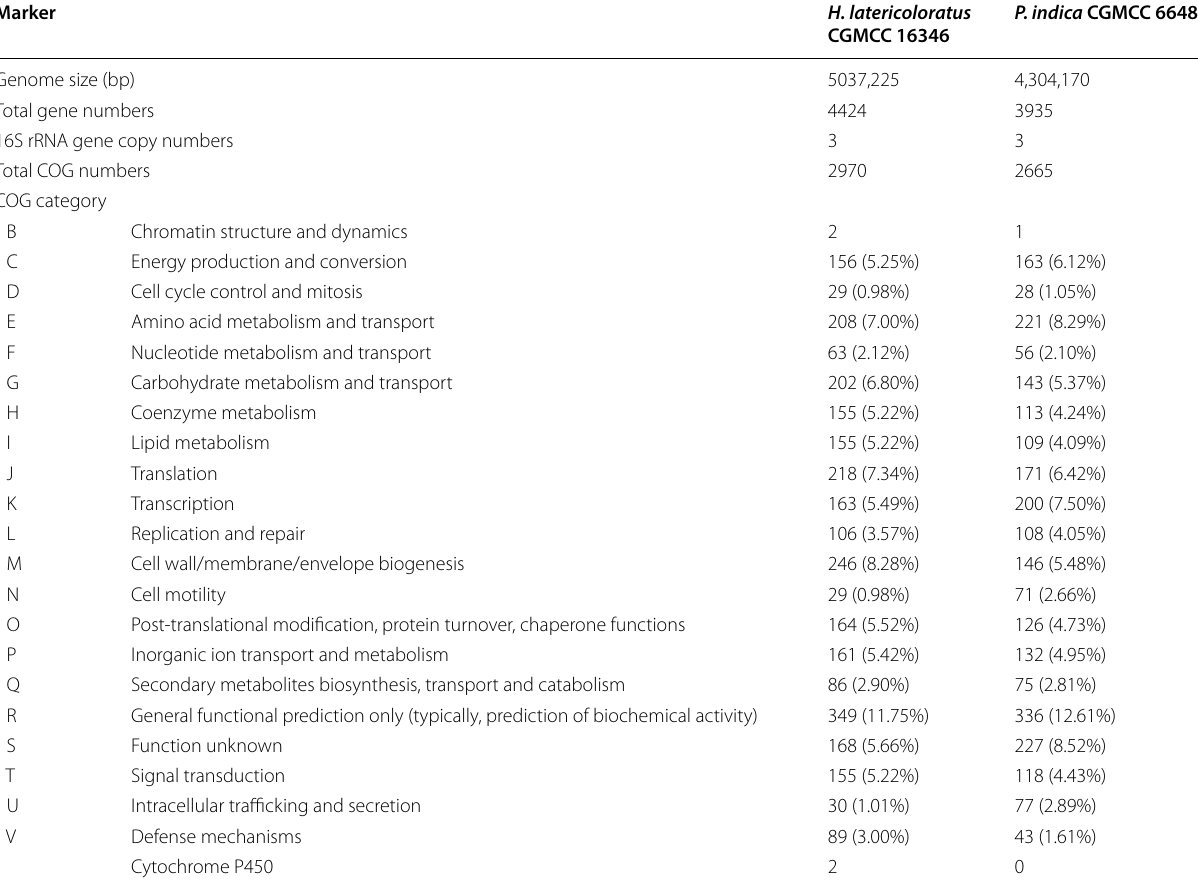
Table 3 Genomic features defining the lifestyle of oligotrophic H. latericoloratus CGMCC 16346 and copiotrophic P. indica CGMCC